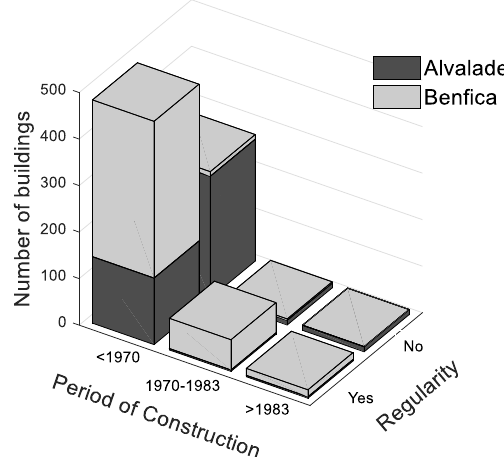
Figure 10. Distribution of buildings in function regularity in elevation.